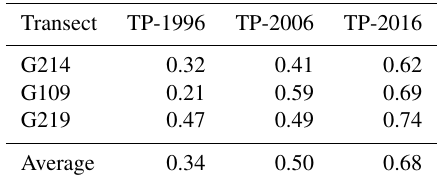
Table 4. Kappa coefficient statistics in three transects of three